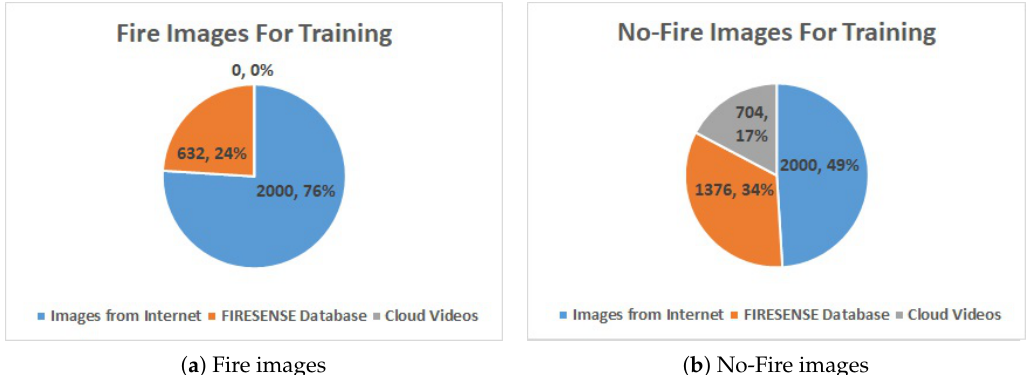
Figure 2. Image distribution of training